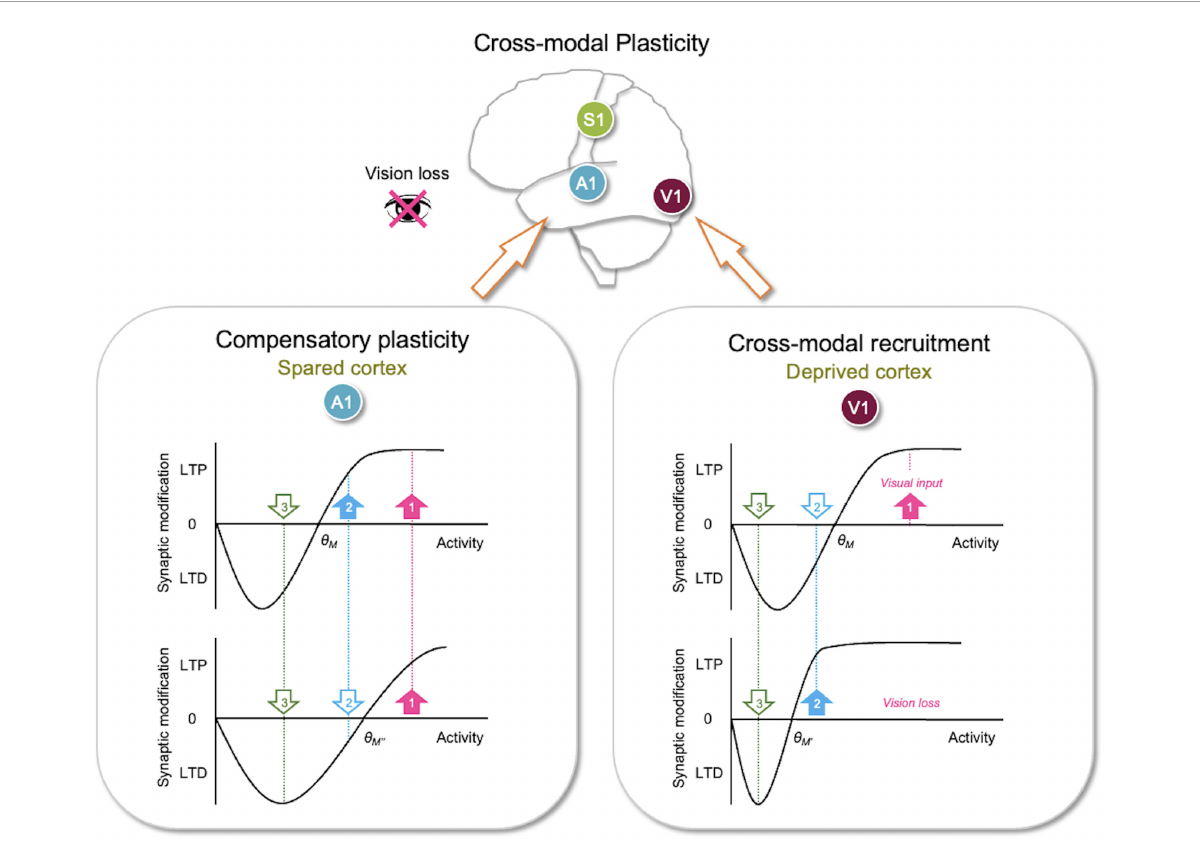
FIGURE2 Metaplasticity sliding threshold model to explain adult cross-modal plasticity. Sliding threshold model can account for synaptic plasticity observed in the deprived sensory cortex (cross-modal recruitment) and the spared sensory cortices (compensatory plasticity). (Lower right panel) The sliding threshold model states that when past activity is low, the synaptic modification threshold ( θ m) slides down (from θ M – θ M (cid:48) ). This is expected to be the case in primary visual cortex (V1) with vision loss. Lower θ m ( θ M (cid:48) ) now allows the second strongest input (cyan, 2), which carries non-visual input, to potentiate. This may recruit V1 to process other sensory inputs in the absence of vision. The weakest input (green, 3) is still below the lowered θ m ( θ M (cid:48) ), hence stay in the LTD zone. This allows the neurons to maintain selectivity for the newly adopted feature (cyan, 2). (Lower left panel) According to the sliding threshold model, an increase in past activity slides up θ m (from θ M – θ M (cid:48)(cid:48) ) to limit LTP induction and increase the range in which LTD can be induced. Vision loss in adults potentiates feedforward synapses in primary auditory cortex (A1) and reduces inhibition in the auditory thalamus ( Figure 1 ), which is predicted to increase input activity to A1 L2/3 leading to a higher θ m ( θ M (cid:48)(cid:48) ). This causes activity from only the strongest input (pink, 1) to exceed the new θ m ( θ M (cid:48)(cid:48) ) to produce LTP, while the second strongest input (cyan, 2) now falls below the new θ m ( θ M (cid:48)(cid:48) ) and undergoes LTD. This in essence makes A1 neurons more selective, which would aid in the discrimination of auditory signals. Because the sliding threshold maintains a range for LTP and LTD, it is ideally suited to dynamically allow neurons to adopt new features in the absence of their main input to mediate cross-modal recruitment or become more feature selective when there is an increase in overall activity as would occur during compensatory plasticity. Filled upward pointing arrows, inputs with activity that surpasses θ m, which will undergo LTP. Open downward pointing arrows, inputs with activity that falls below θ m, which will undergo